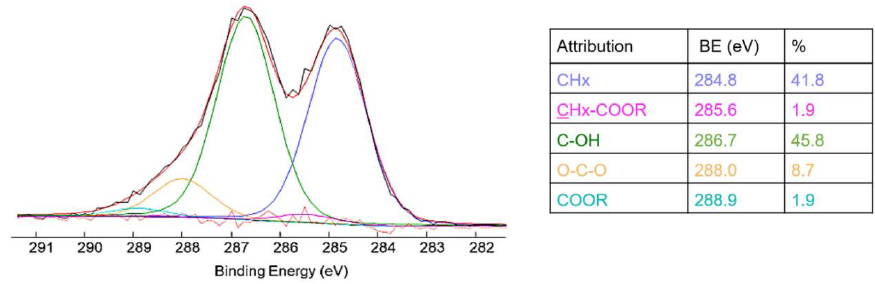
Figure 2. Curve fitting of the high-resolution C1s spectrum and the relevant attributions, BEs values and At%. The uncertainty on the BEs was ±0.2 eV. and At%. The uncertainty on the BEs was ± 0.2